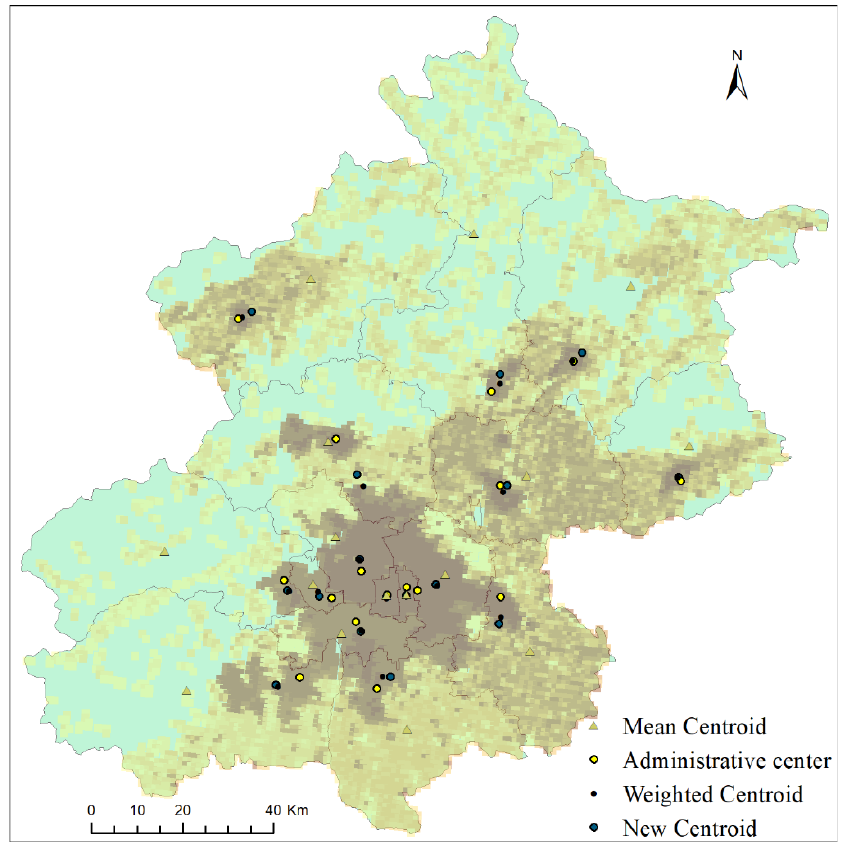
Figure 9. Comparison of Mean Centroid, Administrative Center, Weighted Centroid, and New Centroid.